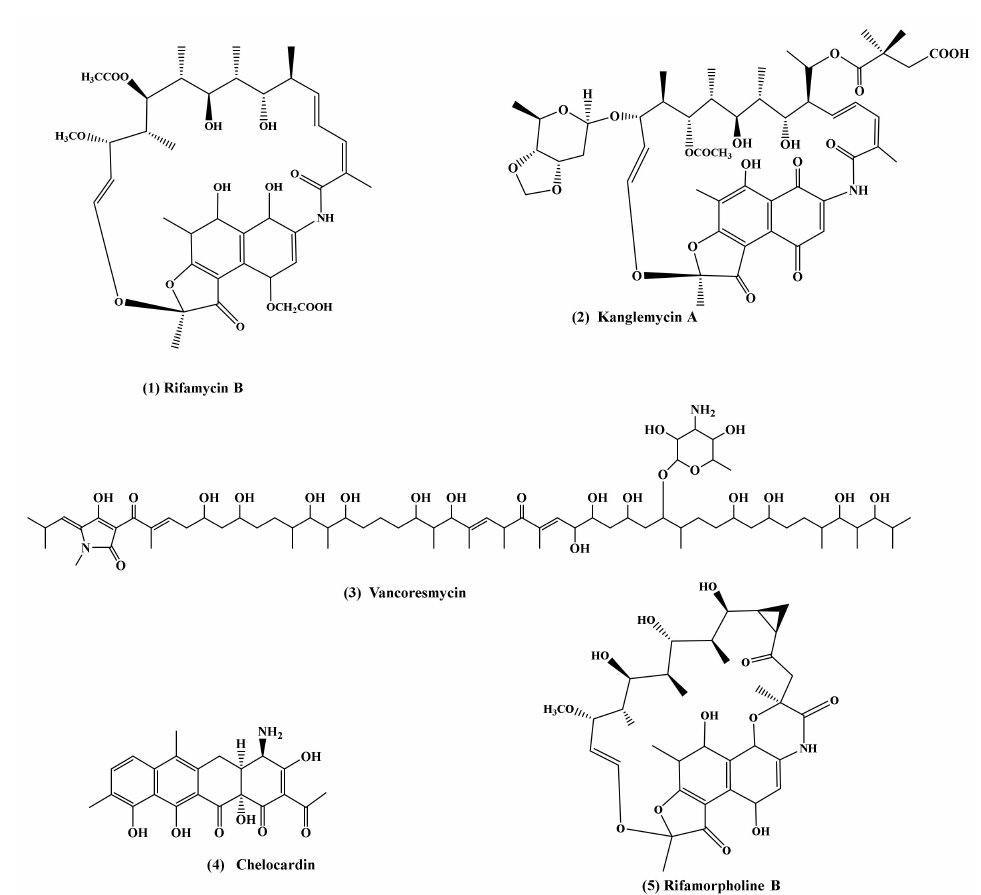
Figure 3. Polyketide antibiotics: ( 1 ) rifamycin B, ( 2 ) kanglemycin A, ( 3 ) vancoresmycin, ( 4 ) chelocardin, ( 5 ) rifamorpholine